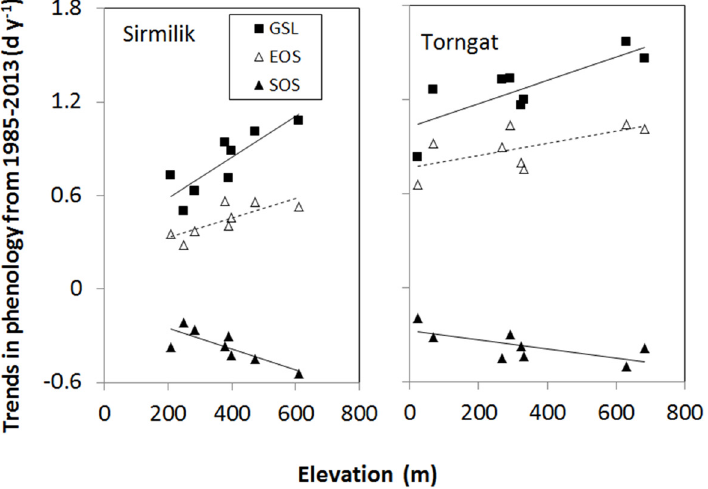
Figure 6. Relationships between SOS, EOS, or GSL trends during 1985–2013 and elevation for tundra classes in the Sirmilik NP and the Torngat Mountains NP. Statistics for these relationships are listed in Table 4.